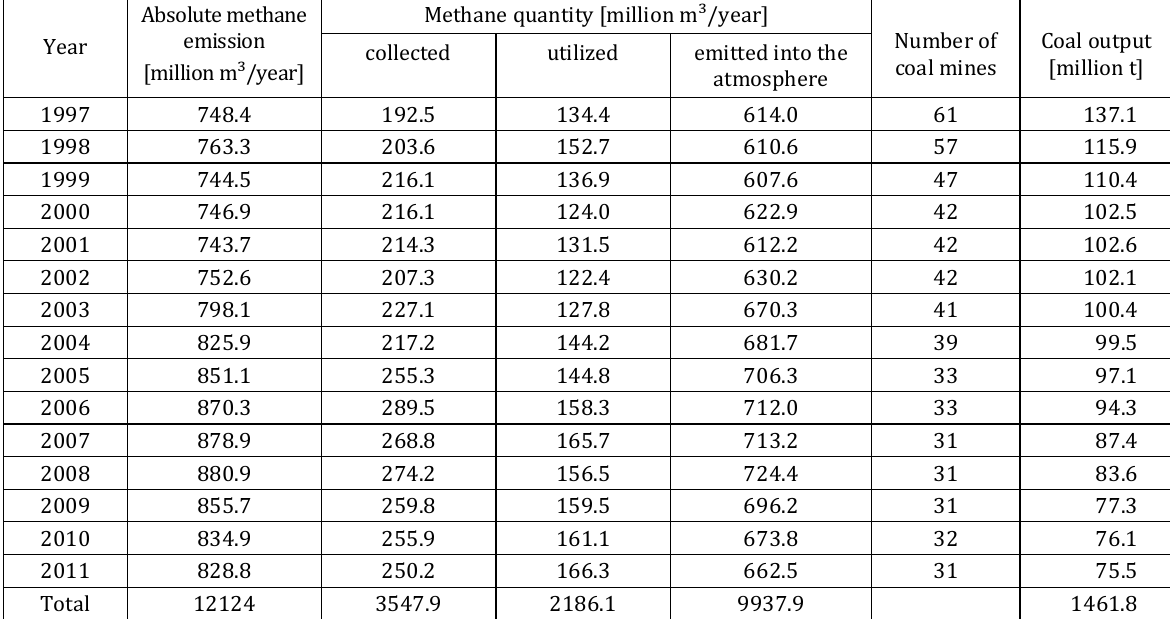
Table 3. Absolute methane emission and the quantity of methane collected, utilized and emitted into the atmosphere in the USCB, after Krause & Sebastian